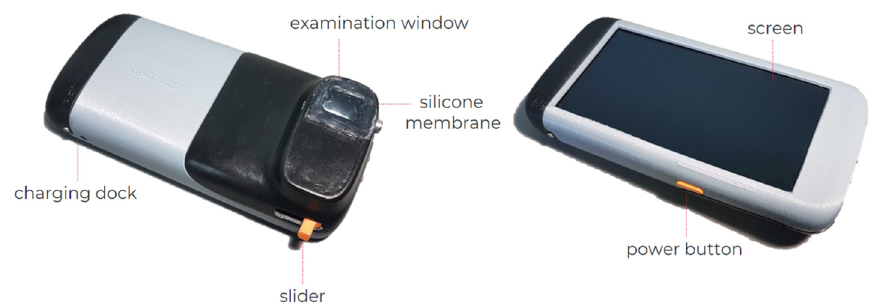
Figure 1. The Dermus SkinScanner device with its main components, including an examination window with a silicone membrane cover, screen, charging dock, power button and slider (for mechanical scanning).